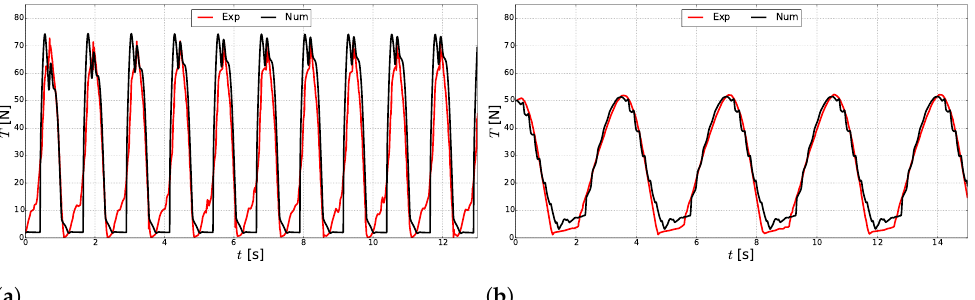
Figure 11. Numerically predicted fairlead tension force magnitudes in comparison to the experimen- tal results. ( a ) T = 1.25 s. ( b ) T = 3.5 s.